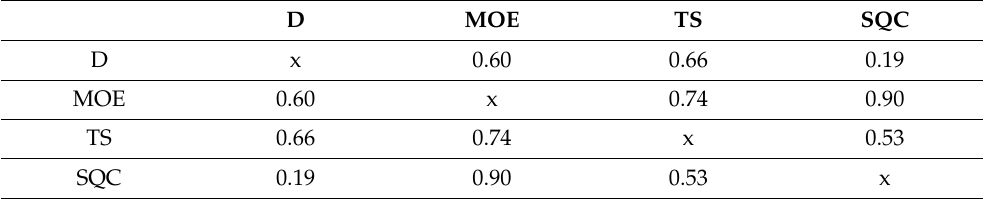
Table 8. Pearson correlation of examined properties at breast height: density, modulus of elasticity, tensile strength, and strength-to-density